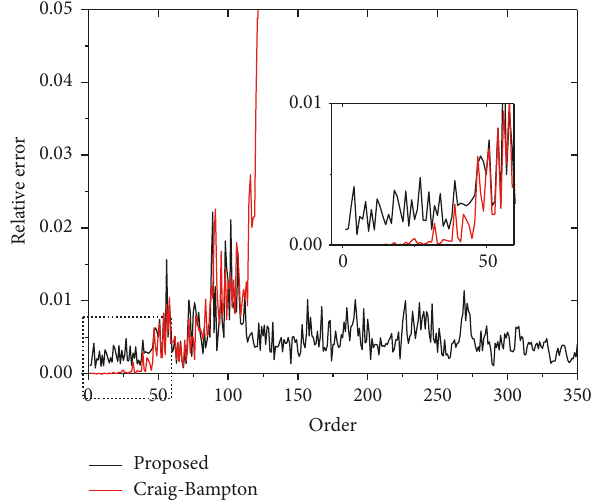
Figure 11: The relative error of mode frequency, convergence comparison between the proposed G s matrix (281 modes each) and the Craig-Bampton method (50 modes for each component and 927 constraint modes).